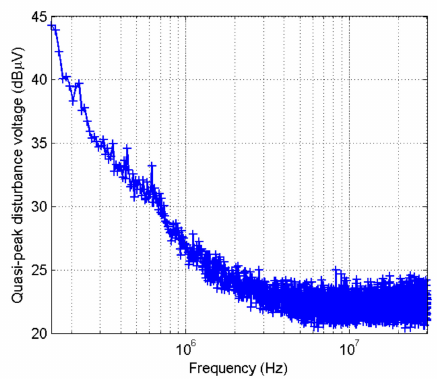
Figure 4. Testing for the conducted EMI. Reference measurement results for a test circuit with no device under the test connected (LISN network unloaded, network output open). All noises are well below the 45-dB µ V level, which we consider as the background noise